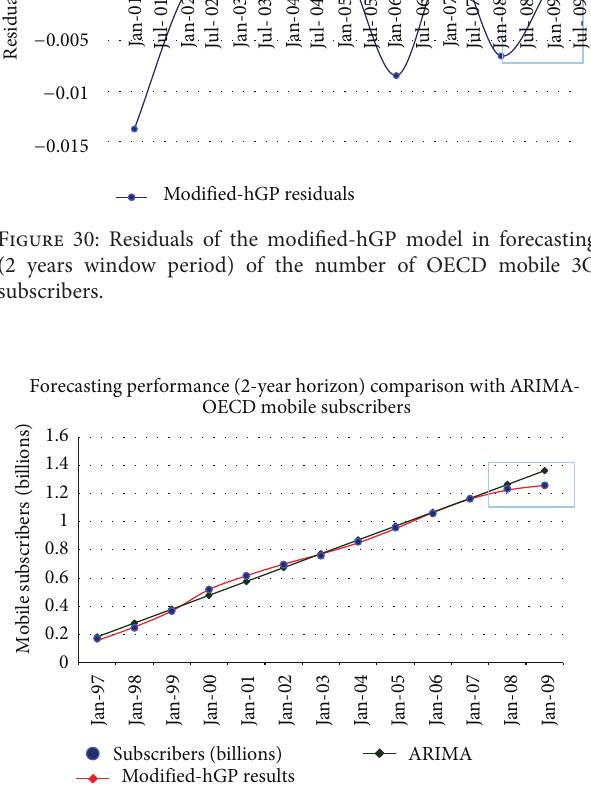
Figure 31: Comparison of the forecasting performances of modified-hGP with ARIMA model (forecast period—2 years ahead).